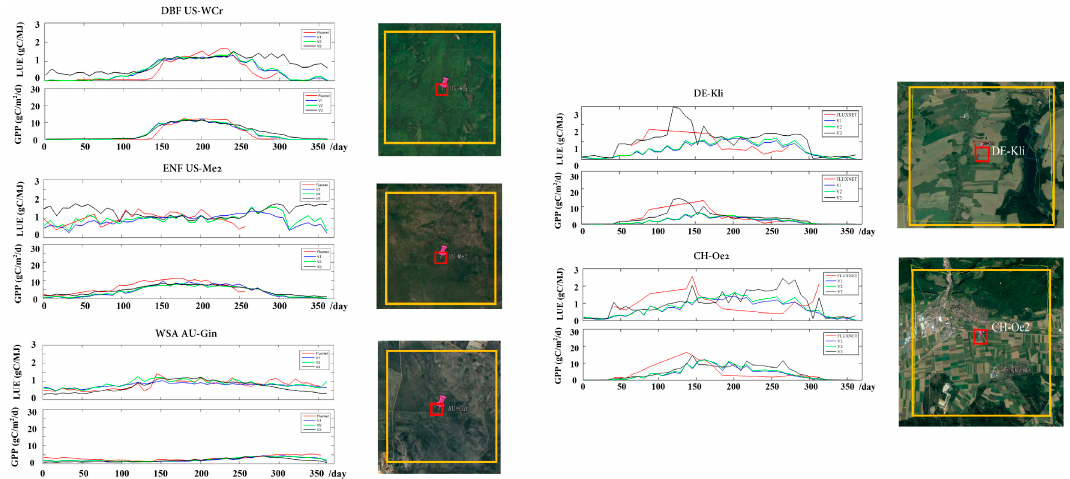
Figure 13. Left: LUE and GPP curves and land surface images in homogeneous sites. US-WCr, US-Me2 and AU-Gin); right: LUE and GPP curves and land surface images in heterogeneous sites (DE-Kli and CH-Oe2) (red rectangles cover 500 m × 500 m land, yellow rectangles cover 5000 m × 5000 m land.